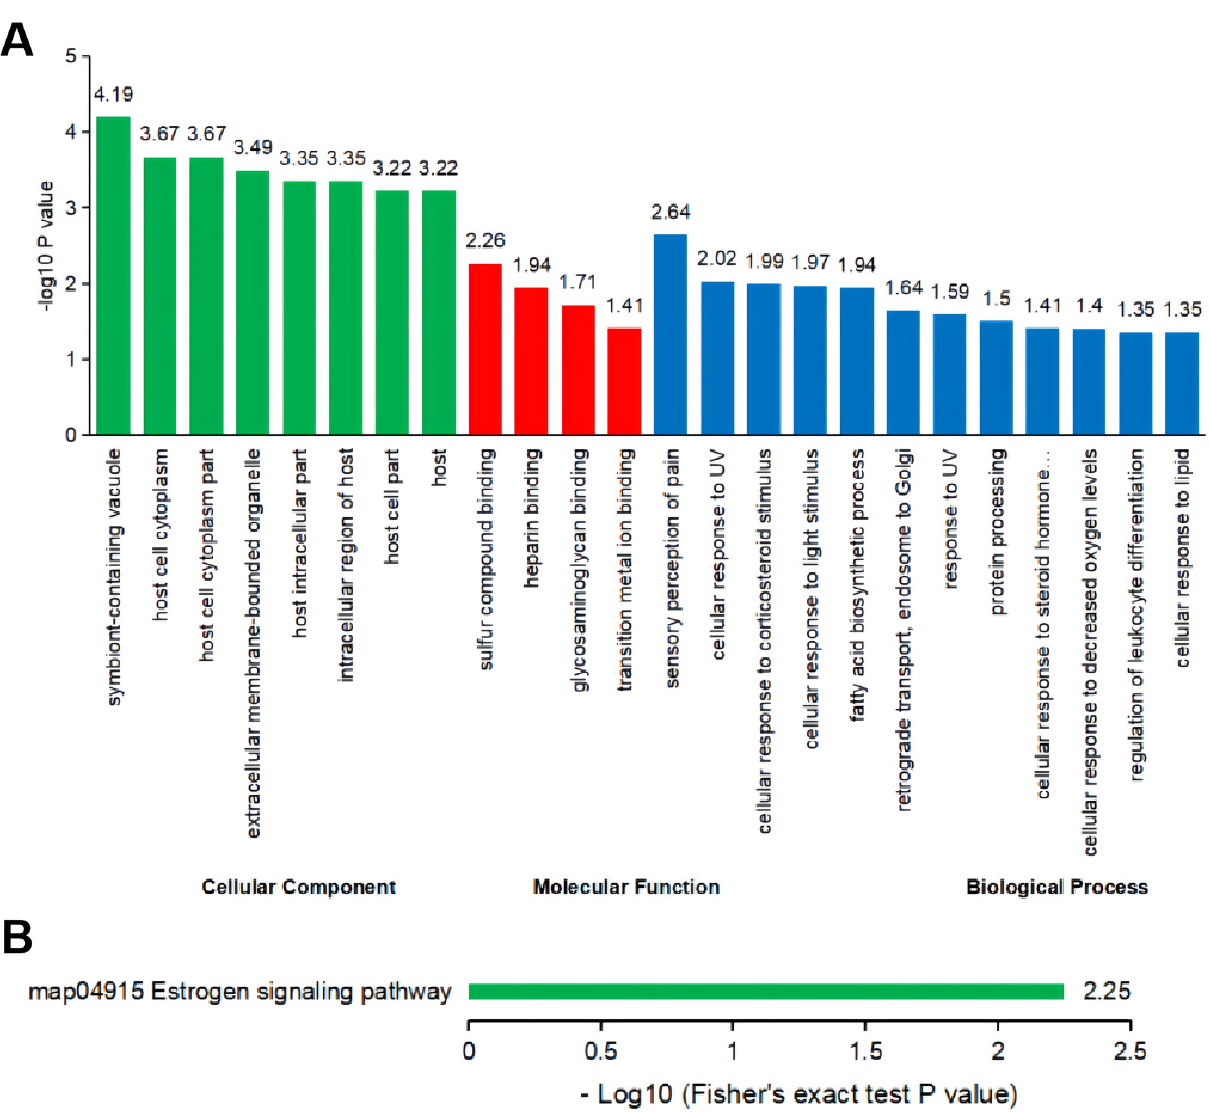
PLOS ONE | https://doi.org/10.1371/journal.pone.0273703 September 15,